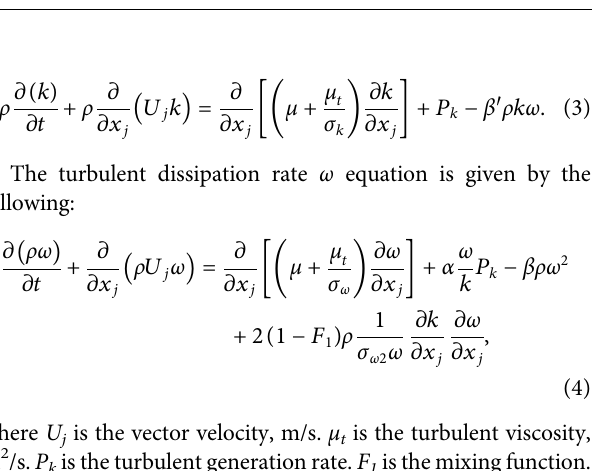
Frontiers in Energy Research |